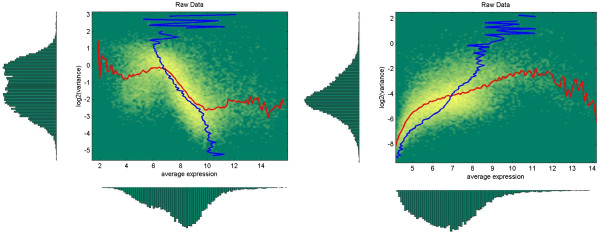
Distribution of features in the two-dimensional space of log2(variance) and average expression. Data for two different pre-processing methods: MAS5 – left panel and RMA – right panel from data set GSE6011 (see Table
1) consisting of 37 samples. Blue line provides the mean E[μ |log2(vT)] under fixed variance and red line the mean E[log2(vT) | μ] under fixed average expression. The following colour scheme is used for plotting 2D distribution: green – minimum (0), yellow – maximum. Bright yellow spots therefore indicate high density location of features. On each panel, marginalized distribution of features over variance is shown on the left side and marginalized distribution over average expression is shown at the bottom of the panel.